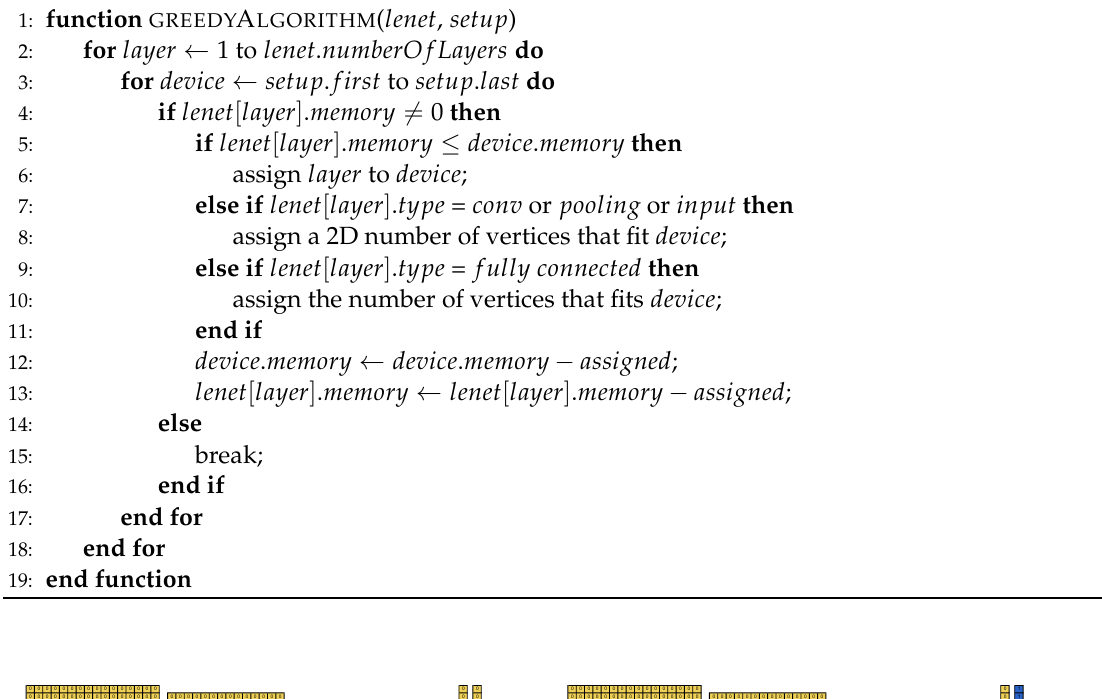
Algorithm 3 Greedy algorithm for communication reduction.